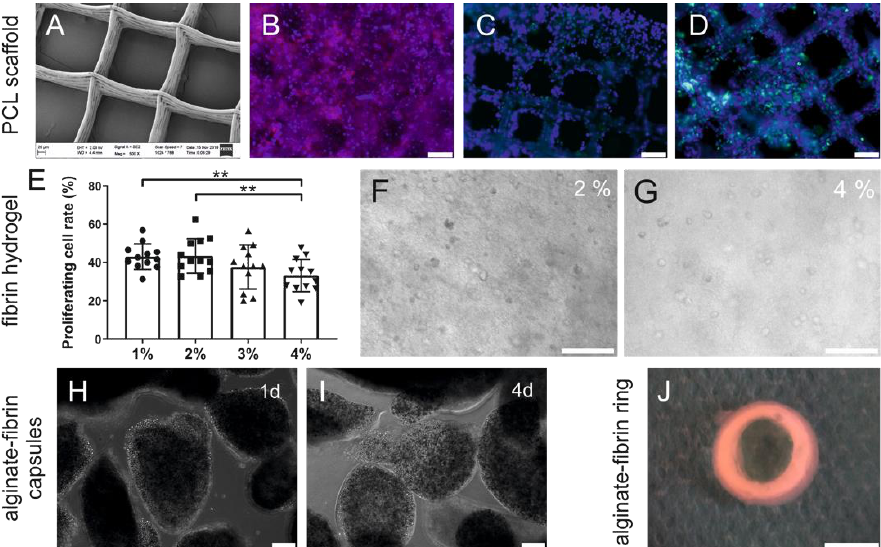
Figure 2. Cell morphology, attachment, distribution, and proliferation in PCL scaffolds, fibrin, and alginate – fibrin hydrogel. ( A ) Morphological structure of PCL scaffold using SEM. ( B ) Immunofluo- rescence for wheat germ agglutinin (red) combined with Hoechst33342 counterstaining (blue) to visualize the nuclei on HTB-26 cells seeded on PCL scaffolds after 7 d culture. Scale bar 100 μm. ( C , D ) Representative images of HTB-26 seeded on PCL scaffolds with cytokeratin immunofluores- cence (green) ( C ) and cell proliferation detected using Ki67-immunofluorescence (green) after 3 d culture ( D ). Counterstaining with DAPI (blue) to visualize the nuclei. Scale bar 100 μm. ( E ) Effect of different fibrin concentrations on cell proliferation determined by Ki67 immunofluorescence at 18 d. S cale bar 100 μm. ( F , G ) Morphology and distribution of HTB-26 cells cultured in 2% and 4% fibrin hydrogels at 4 d. Scale bar 100 μm. ( H , I ) Representative images of HTB-26 cells encapsulated in alginate – fibrin capsules at 1 d ( H ) and 4 d ( I ). Scale bar 100 μ m. ( J ) Macroscopic structure of the 3D- printed alginate – fibrin ring. Scale bar 10 mm. ** p <0.01.